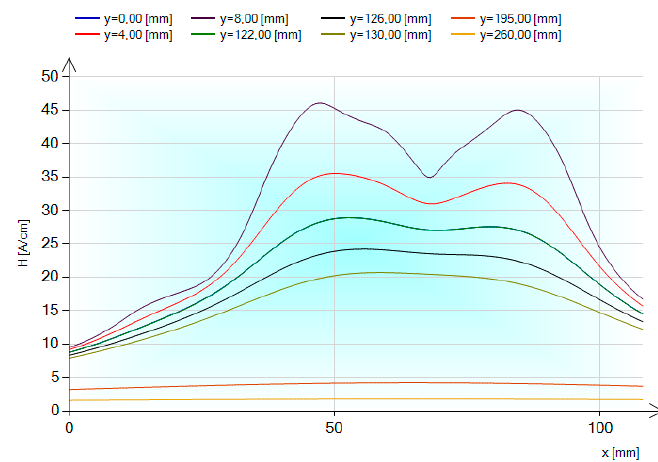
Figure 12. The distribution of magnetic field intensity of an unshielded busbar system for x = var (variables) and different values of y = const in the case of current symmetry.